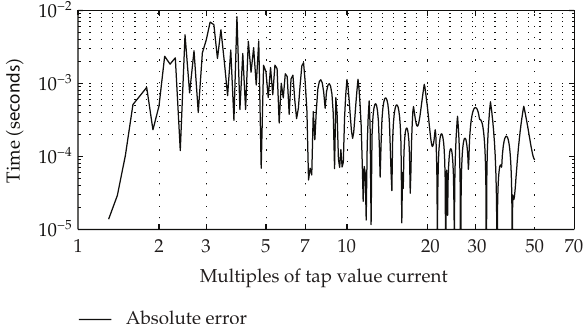
Figure 4: Absolute values of error for TDS (cid:8) 3 CO-8 relay.